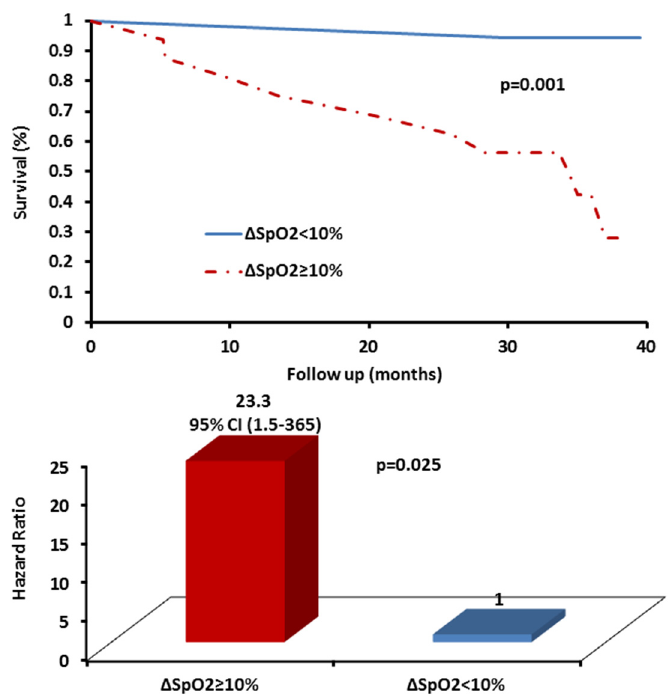
Figure 2. Kaplan–Meir survival curves and hazard ratio for exertional desaturation ( ∆ SpO 2 ) threshold in patients with idiopathic pulmonary fibrosis.